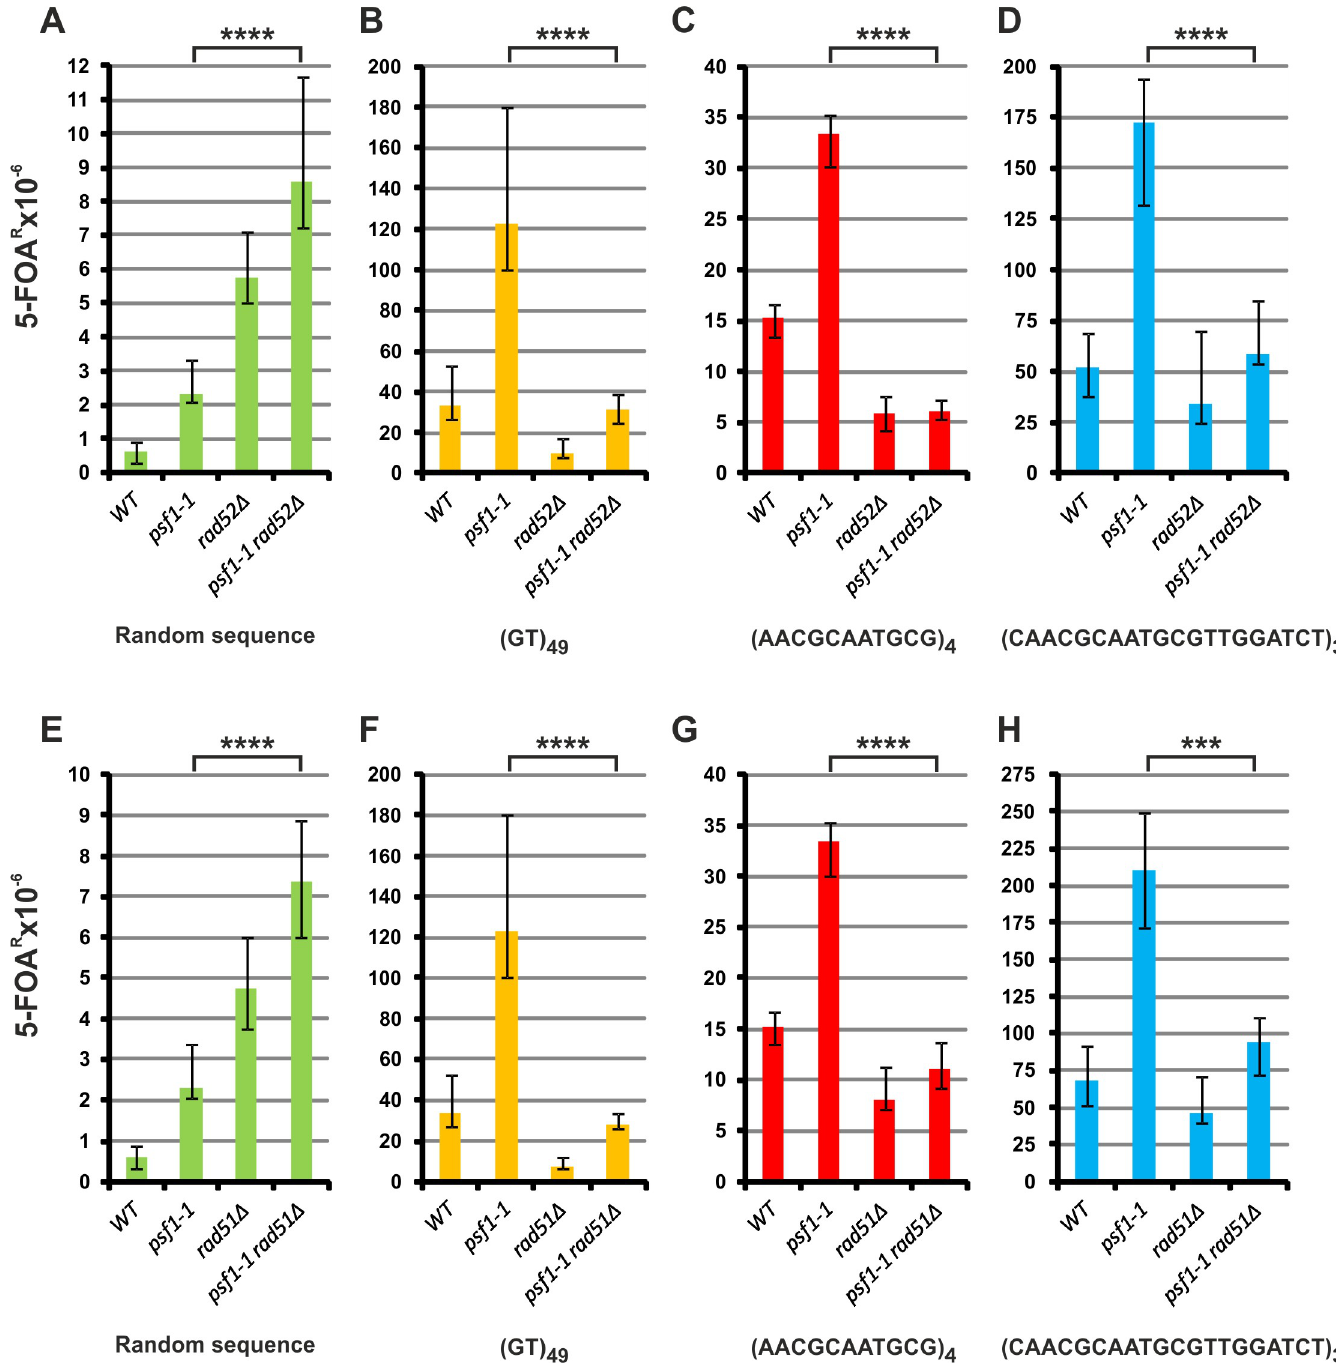
Fig 5. The instability of repeat tracts in psf1-1 cells depends on the recombinases Rad52 (A-D) and Rad51 (E-H). The 5-FOA R mutation rates were determined at 23˚C for yeast cells with the indicated genotypes carrying plasmids with the analyzed sequences; the values are medians with 95% confidence intervals calculated from data for at least ten cultures of each strain; the p values for psf1-1 rad52 Δ or psf1-1 rad51 Δ versus psf1-1 mutant strains were calculated using the nonparametric Mann- Whitney U statistical test ( ���� p � 0.0001; ��� p � 0.001). All associated p -values are presented in the S1 Table. https://doi.org/10.1371/journal.pgen.1008494.g005 PLOS Genetics | https://doi.org/10.1371/journal.pgen.1008494 December 9,